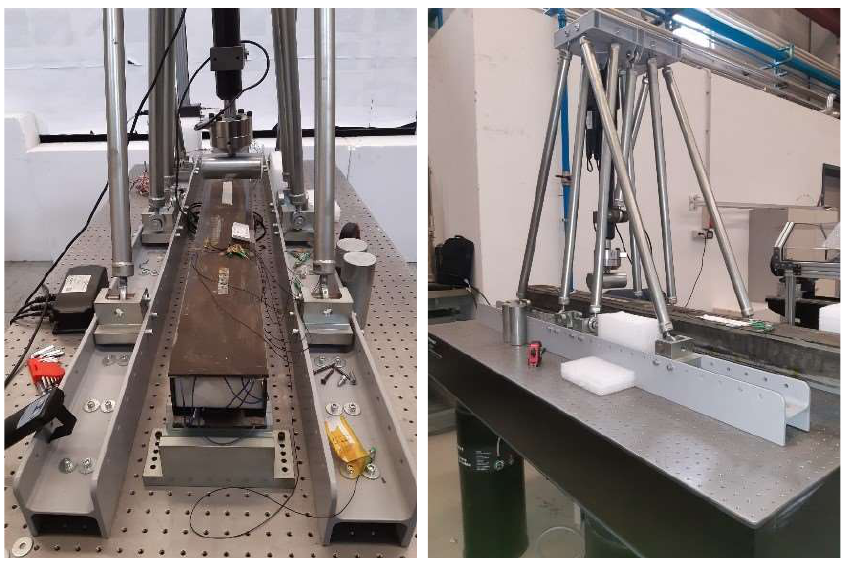
Figure 32. Test rig with the composite beams installed: front ( left ), and lateral ( right ) view.